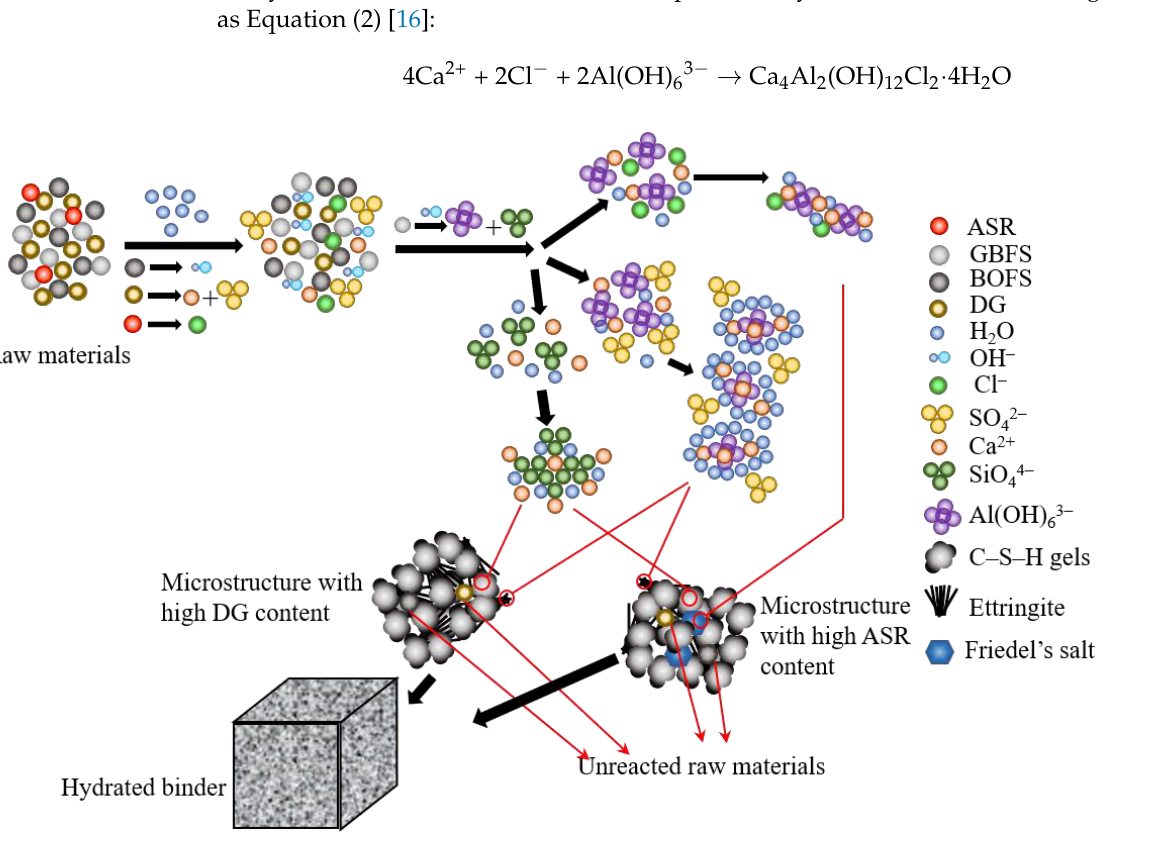
Figure 11. Hydration mechanism of binders with ASR content.